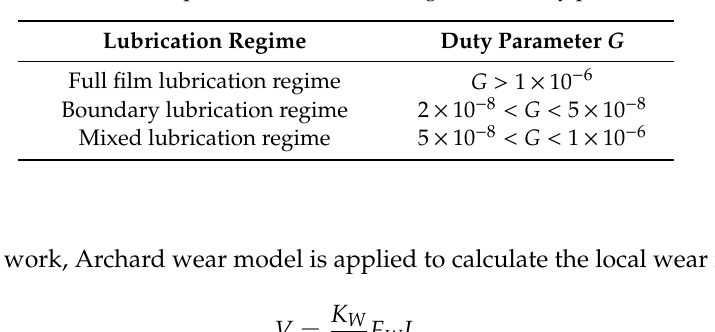
Table 1. Relationship between lubrication regime and duty parameter G